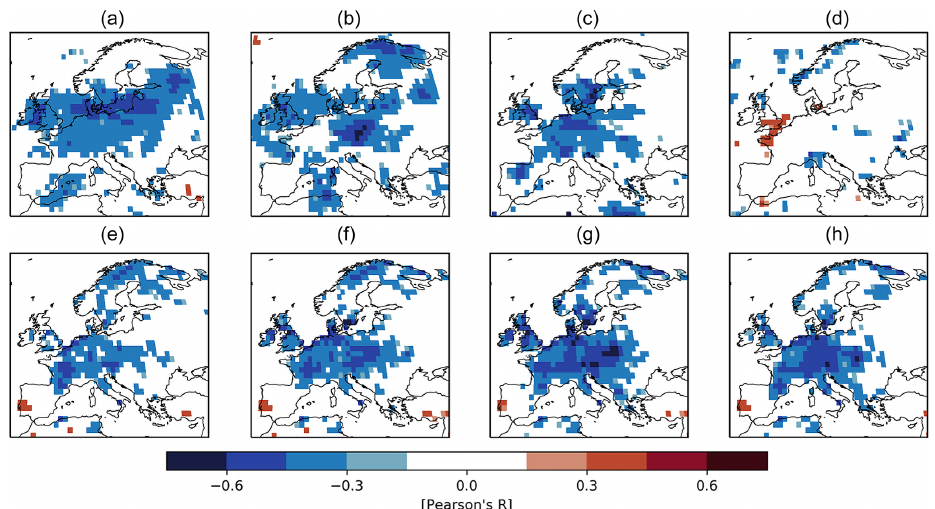
Figure 7. Links between the first δ 18 O component and the modelled δ 18 O in soil water and precipitation from nudged climate simulations with ECHAM5-wiso (Butzin et al., 2014). Panels (a–d) show the correlation between the first δ 18 O component (PC1) and δ 18 O in precipita- tion for winter (a) , spring (b) , summer (c) , and autumn (d) . Panels (e–h) are the correlation maps for PC1 and δ 18 O in soil water for winter, spring, summer, and autumn. For all maps, the significant grid cells are